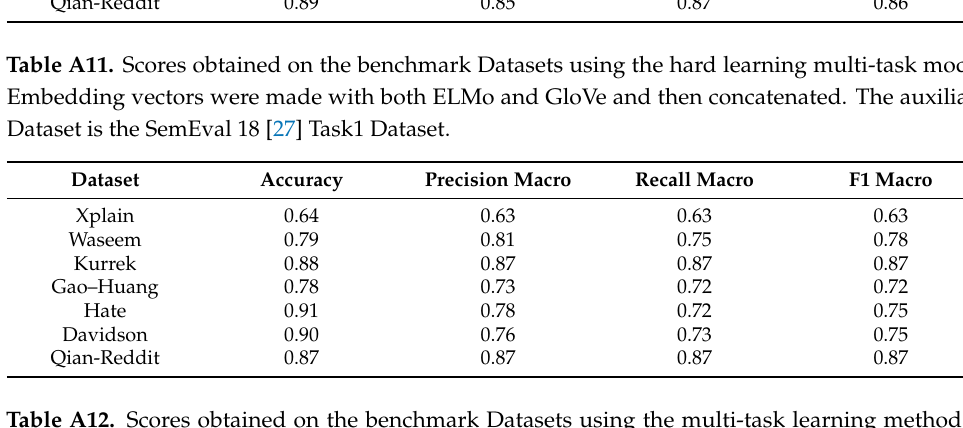
Table A12. Scores obtained on the benchmark Datasets using the multi-task learning method in which only the last layers were separated. Embedding vectors were made with both GloVe and ELMo and then concatenated. The auxiliary Dataset is the SemEval 18 [27] Task1 Dataset.